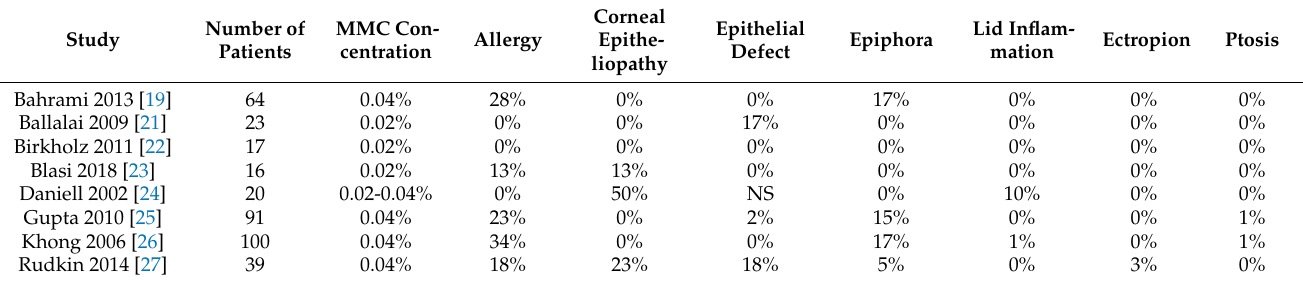
Table 1. Ocular surface complications of topical mitomycin C for ocular surface squamous neoplasia.